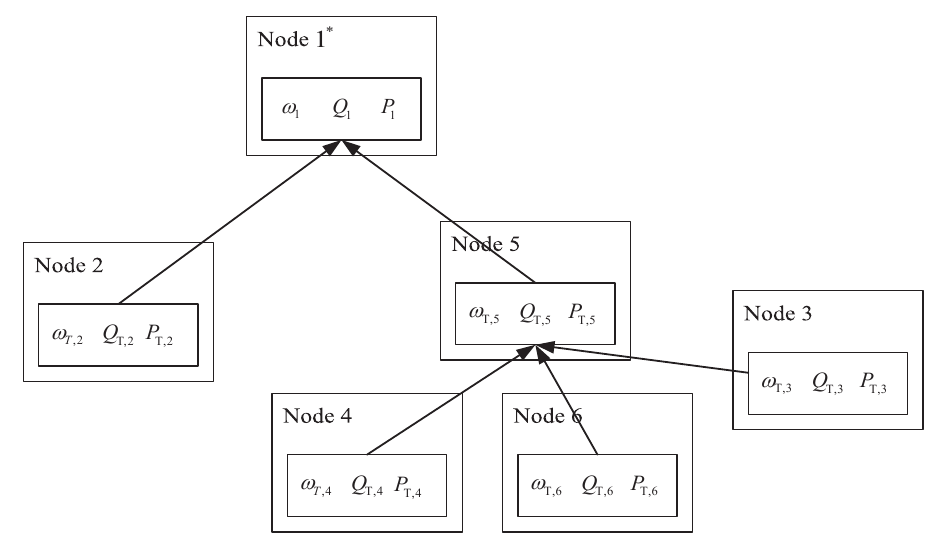
Figure 3. The message processing of the variables among intelligent